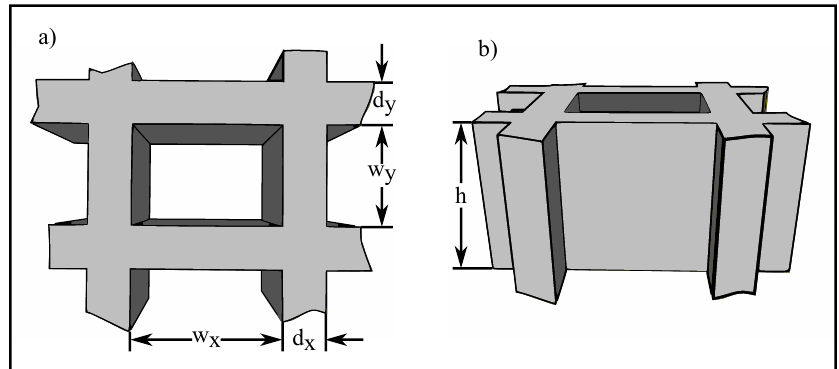
Figure 2. Schematic drawing of a hollow waveguide: ( a ) shows a top view and ( b ) shows a tilted side view of a hollow waveguide. The grey-colored structure are the surrounding gold sidewalls. The rectangular spacing in between is the air-filled hollow